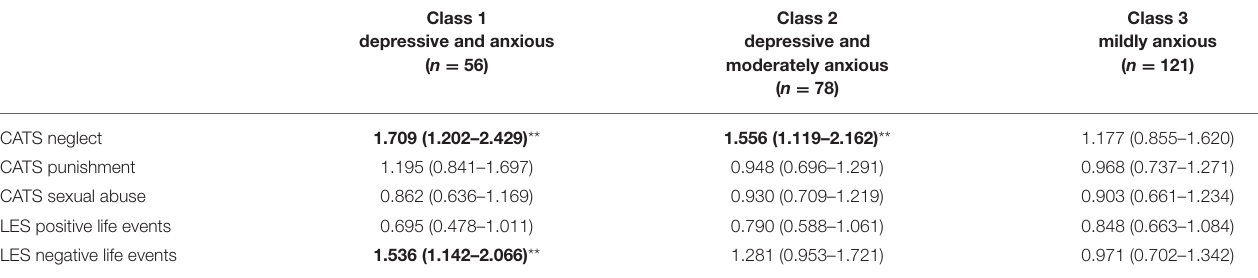
TABLE 3 | Environmental risk factors predicting class membership: odds ratios and 95% confidence intervals from multinomial logistic regression.